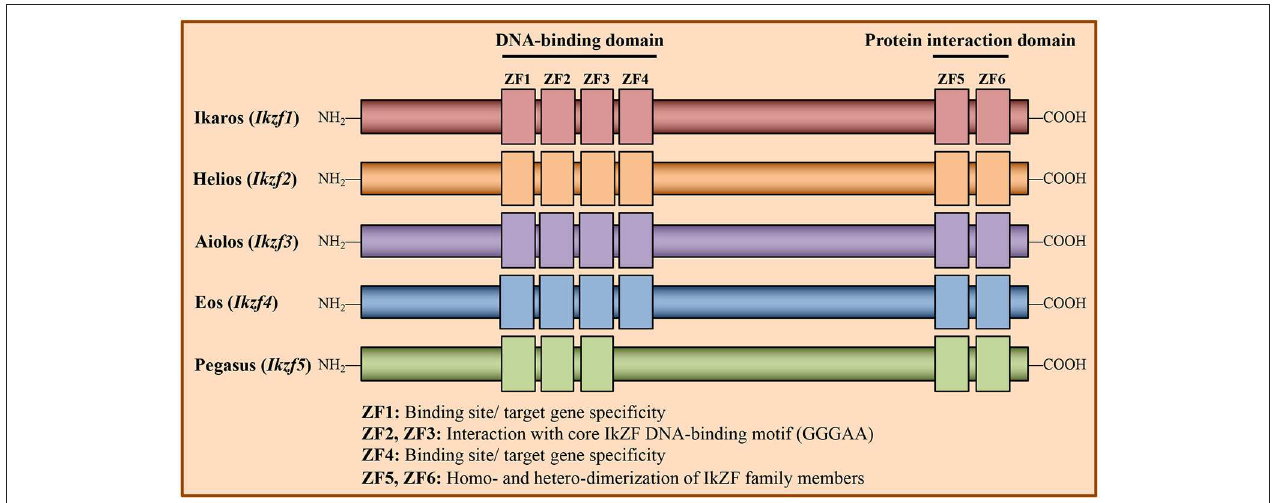
FIGURE 1 | Structure of Ikaros Zinc Finger transcription factor family members. Members of the Ikaros Zinc Finger (IkZF) family of transcription factors are known regulators of hematopoietic cell development, including that of CD4 + T cells. The IkZF family consists of five members: Ikaros (encoded by the gene Ikzf1 ), Helios ( Ikzf2 ), Aiolos ( Ikzf3 ), Eos ( Ikzf4 ), and Pegasus ( Ikzf5 ). These factors contain N-terminal zinc finger (ZF) domains, which are responsible for mediating direct interactions with DNA, and C-terminal ZFs, which facilitate homo- and heterodimerization between IkZF family members. Of the N-terminal zinc fingers, ZF2 and ZF3